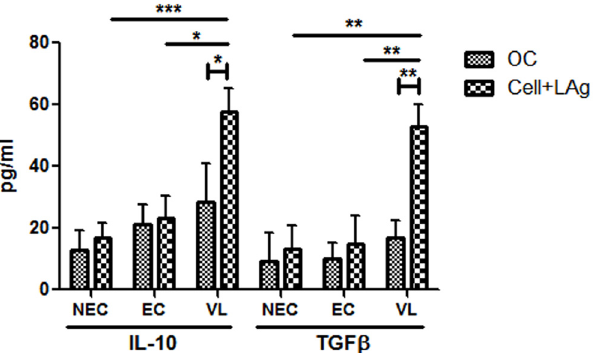
Fig 3. Leishmania -specific cell-mediated immune response in VL patients and healthy controls (ECs and NECs). PBMCs were isolated from VL patients (n = 10), ECs (n = 5) and NECs (n = 10). Cells (2×10 5 / well) were stimulated with 12.5 μ g/ml of LAg for 4 days and cytokines from supernatants were measured by ELISA. IL-10 and TGF β levels (pg/ml) were compared between LAg-stimulated and unstimulated samples (only cell, OC) from VL patients as well as LAg-stimulated samples from ECs and NECs. Data are represented as mean ± SE. P values were calculated using non-parametric Mann-Whitney U test and Unpaired t test; P < 0.05 was considered significant.